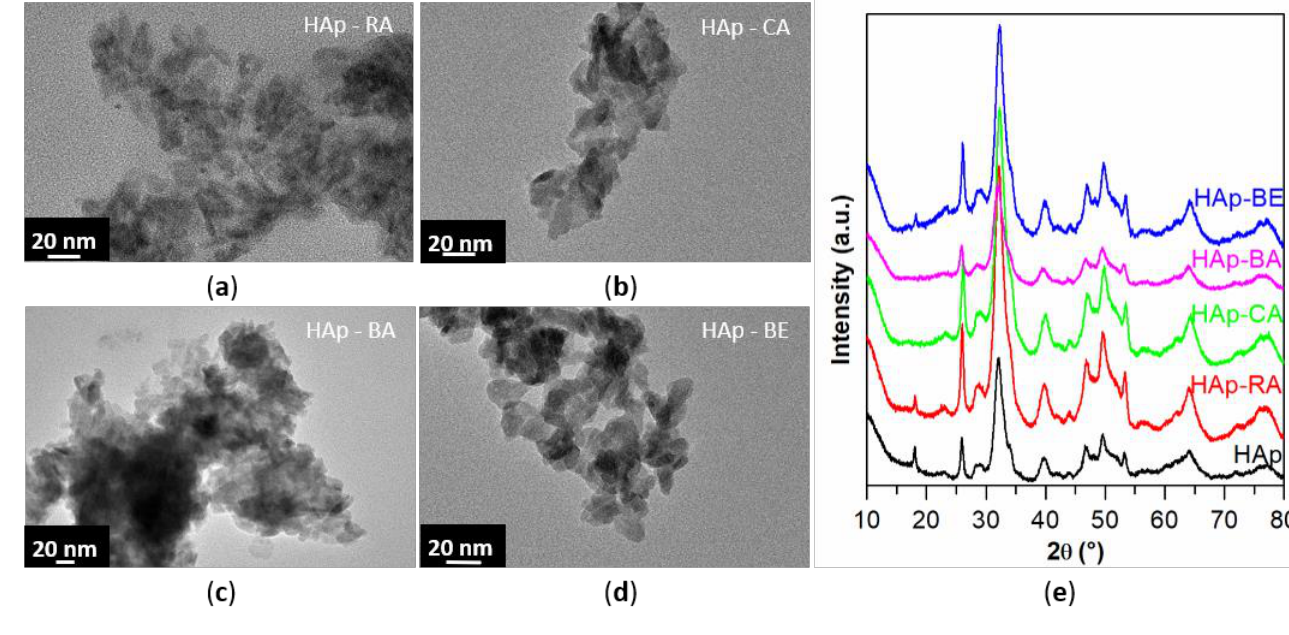
Figure 5. Hydroxyapatite particles synthesized in presence of 0.05 mM polyphenols. ( a ) Superimposition of X-ray diffractogram of HAp NPs, HAp-RA, HAp-CA, HAp-BA, and HAp-BE; TEM images of ( b ) HAp-RA; ( c ) HAp-CA; ( d ) HAp-BA; ( e ) HAp-BE. Table 2. Synthesis of HAp NPs in presence of polyphenols at 0.05 mM and 0.5 mM. Yield, particle dimensions as measured from TEM, crystallite sizes calculated from XRD data, incorporated quantity measured from TGA.